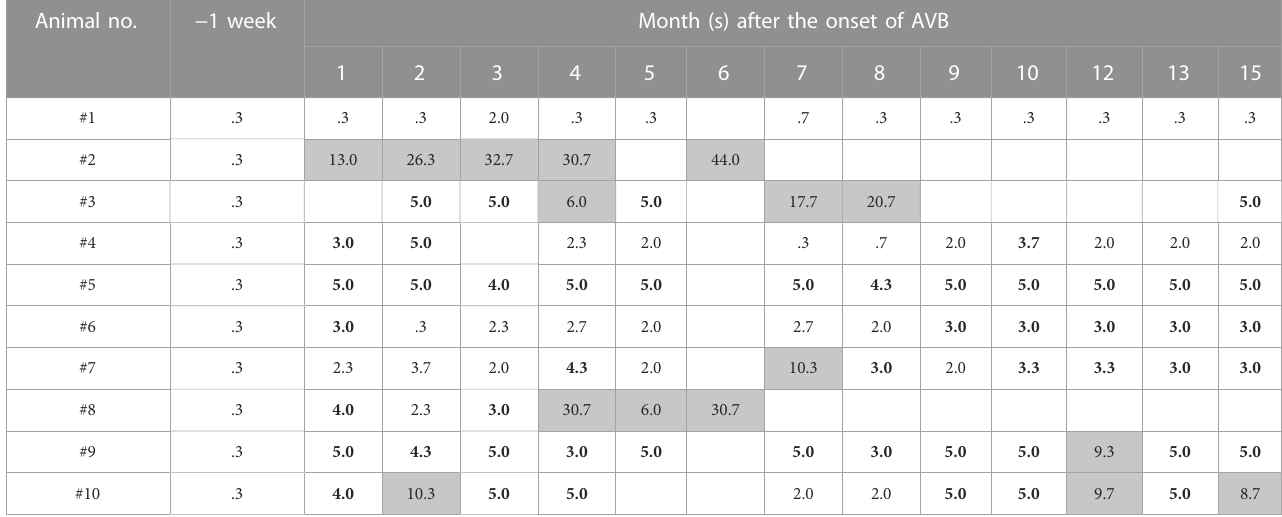
TABLE 3 Time courses of the arrhythmic severity in the atrioventricular block (AVB) monkey 1 – 3 h after oral administration of dl -sotalol hydrochloride (10 mg/kg). Animal